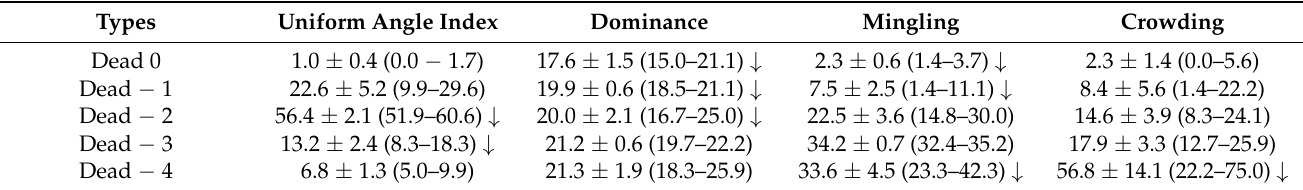
Table 3. The proportion statistics of change types in mortality process